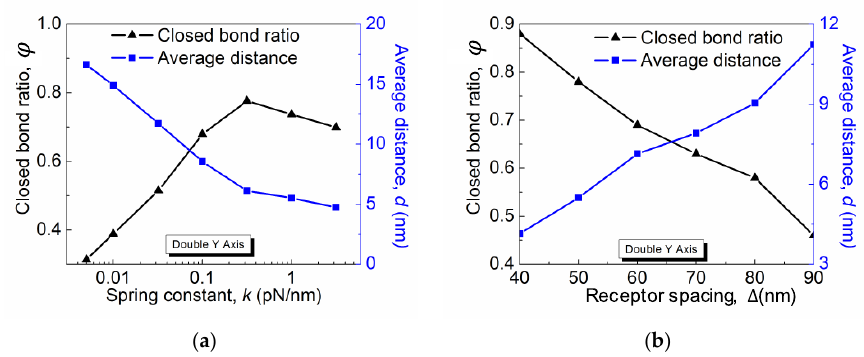
Figure 4. The closed bond ratio as functions of ( a ) the spring constant k and ( b ) the receptor density. Simulation parameters are as follows: p = 4 × 10 −5 pN/nm 2 , h L = −1.2, σ w = 4 nm, and ε w = 0.01 k B T /nm 2 . density. Simulation parameters are as follows: p = 4 × 10 − 5 pN/nm 2 , h L = − 1.2, σ w = 4 nm, and ε w = 0.01 k B T /nm 2